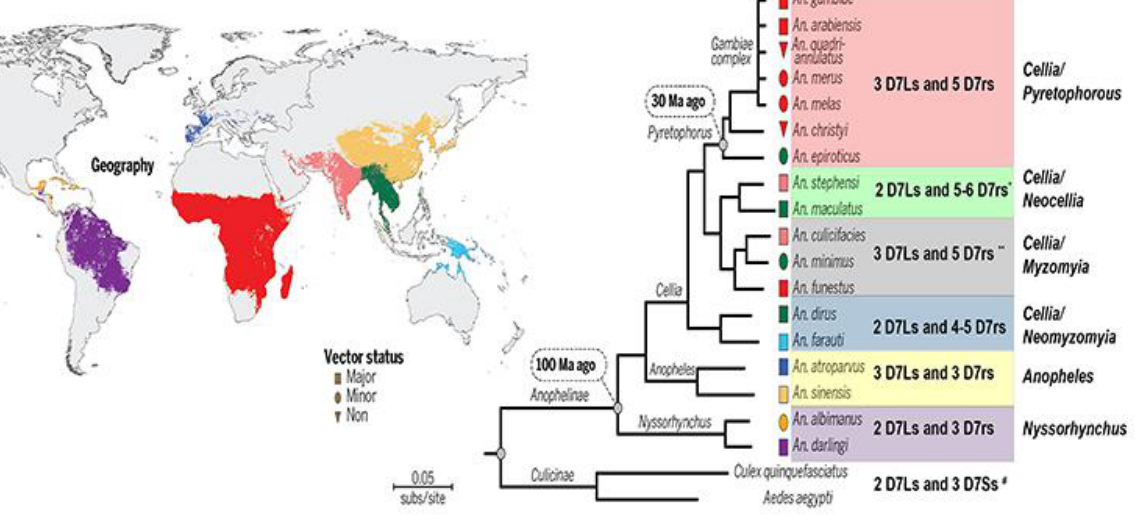
Figure 2. D7 protein family members distribution pattern through Anopheles sub-genus and series and some culicinae species — Geographic distribution and molecular phylogeny (reported by Neaf- sey et al. [58] using aligned sequence of 1085 orthologs) of the different Anophelinae species whose genomes were sequenced so far. Symbols indicate species vector status and their color matches map color indicating their distribution. In the context of this review we further separated them in sub genus series (indicate on the further right) inside colored boxes. The number of long (D7Ls) and short (D7r or D7S) found in the species of each group [29] as well as in some representative Culicinae species are shown in the colored shaded boxes. In Anophelinae mosquitoes D7L2 and L3 forms are always present, and D7L1 only when a third form is present. In Culicinae mosquitoes the only long forms present are D7L1 and D7L2, while D7L3 was absent in the species analyzed. Short forms observed in Culicinae (*) are shorter, truncated forms reason by which they were not denominated as “related”(D7r), but only as “short”(D7S). Figure modified from: Neafsey, D.E.; Waterhouse, R.M.;